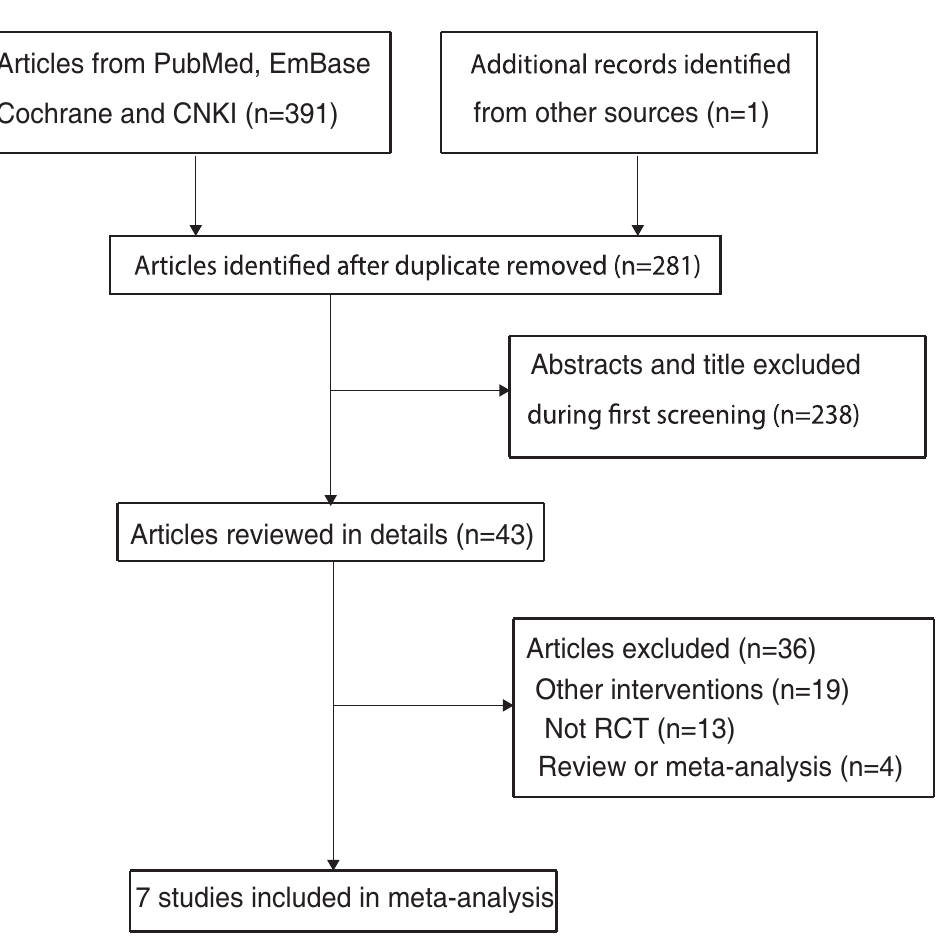
Fig 1. The PRISMA flowchart for the literature search and study